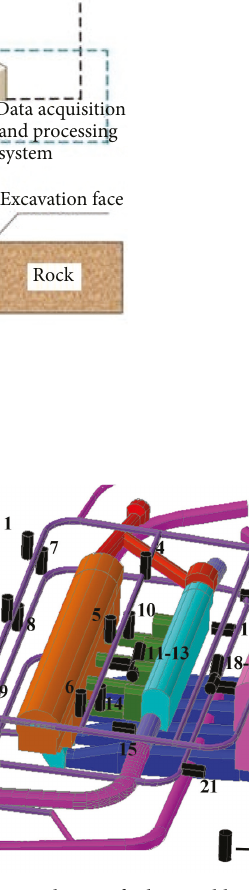
Figure 4: Network topology of the rockburst microseismic monitoring system in Shuangjiangkou underground cavern.